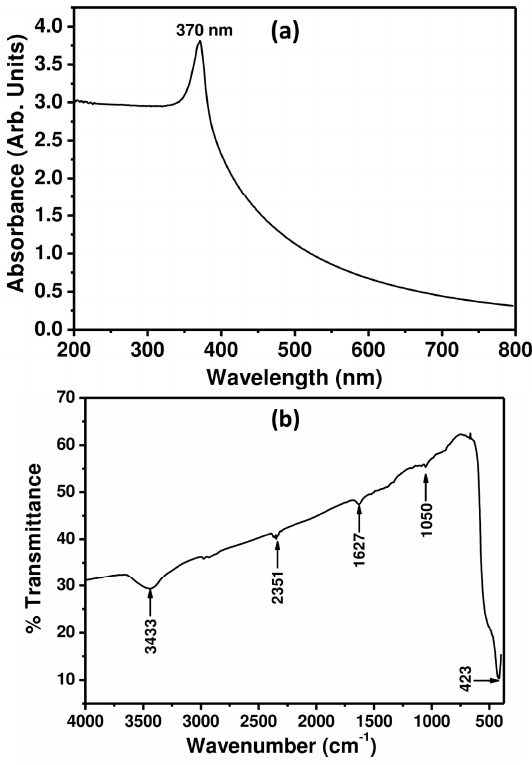
Figure 3. ( a ) UV-Vis and ( b ) FTIR spectra for the as-synthesized ZnO nanopeanuts.